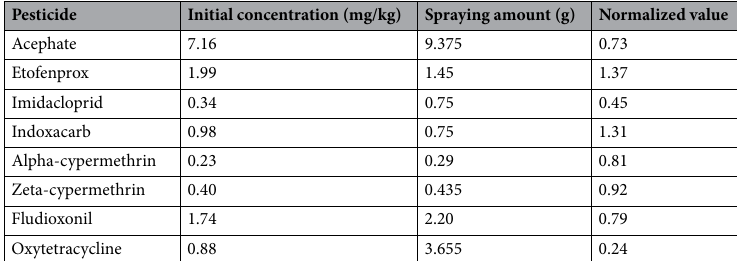
Table 3. Normalized values of the eight pesticides.